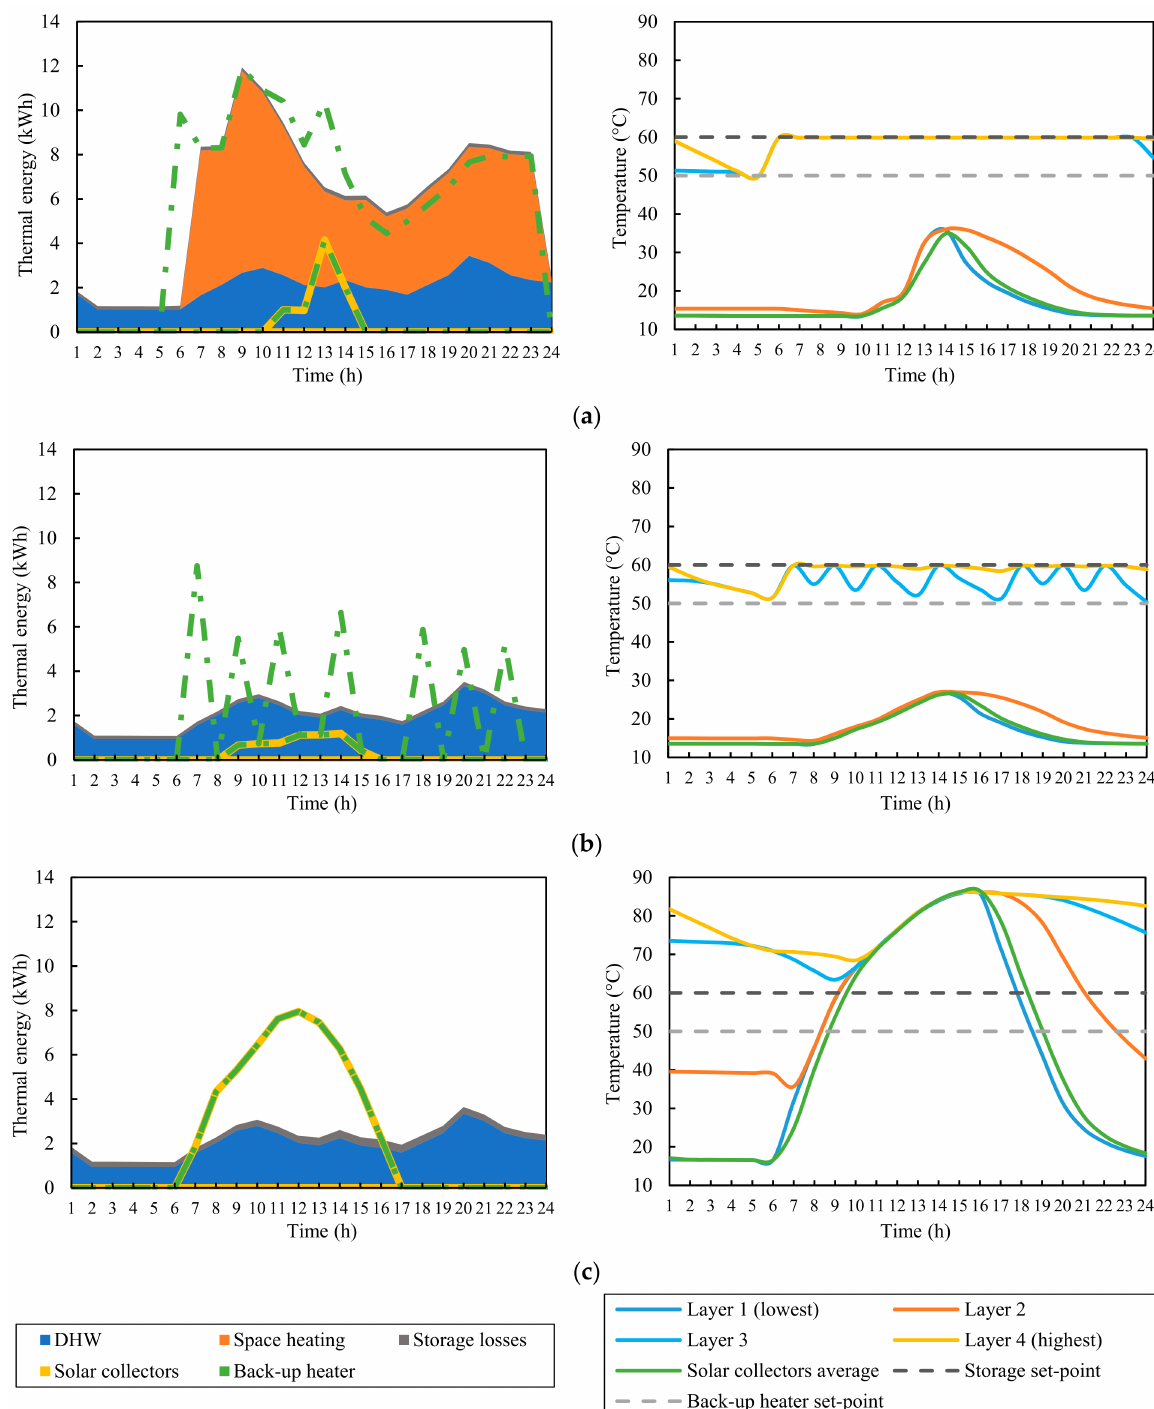
Figure 14. Simulation results for a: ( a ) winter day; ( b ) mid-spring day; ( c ) summer